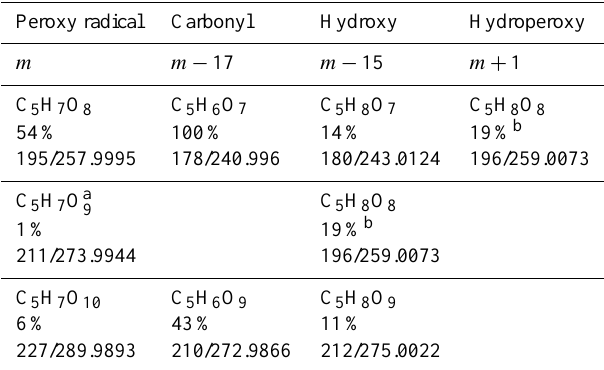
Table 4. HOM observed during ozonolysis of cyclopentene. The second header line shows at which molar masses the termination products are expected relative to the peroxy radical with molar mass m (unit masses). Filled cells indicate that these compounds were de- tected with given elemental composition and relative intensity (sec- ond line in the same cell). Relative intensities were normalized to the largest HOM signal. The third line in the cell gives the molar mass [Da] in unit mass resolution and the precise m/z [Th] at which the molecule was detected as cluster with 15 NO − . 3